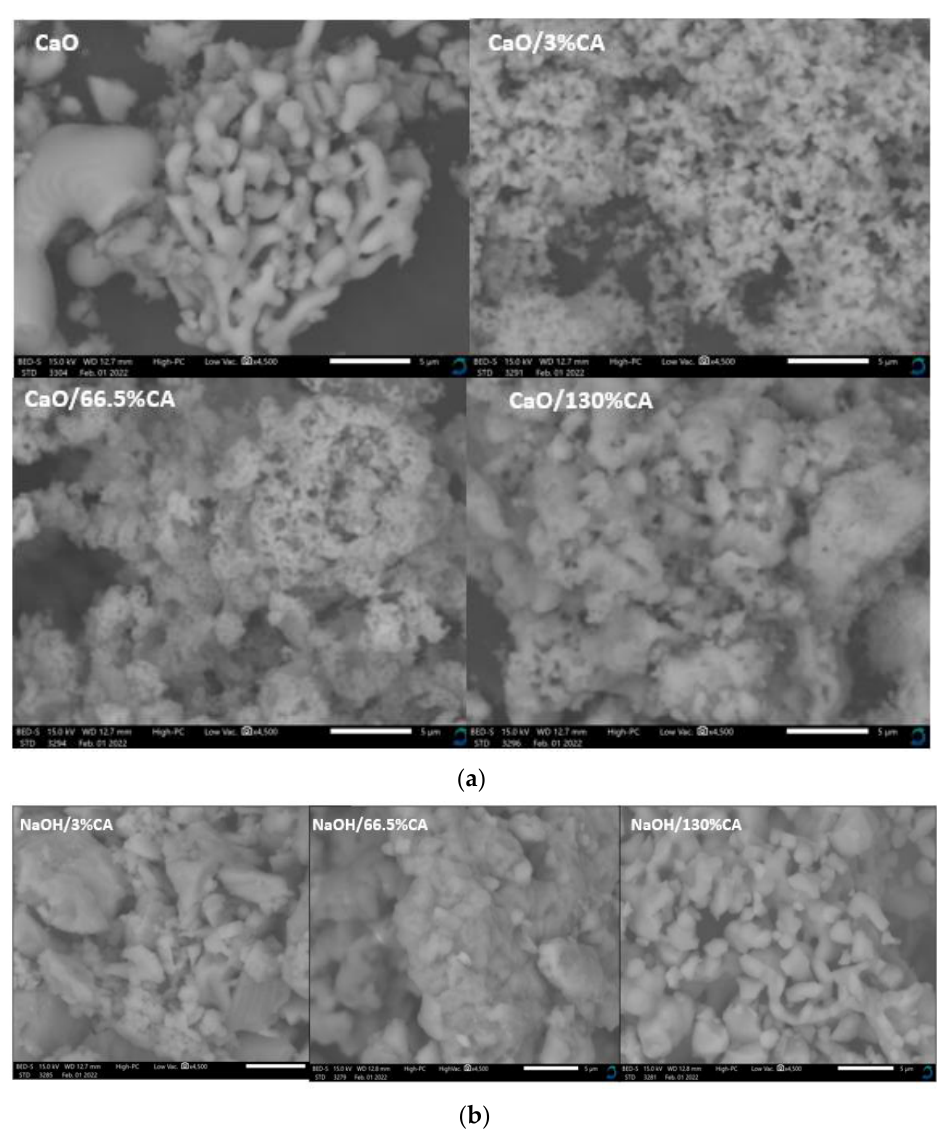
Figure 3. SEM micrographs of the catalysts with varied wt.% loading of citric acid: ( a ) CaO/CA catalysts; ( b ) NaOH/CA catalysts. catalysts; ( b ) NaOH/CA Table 2. XRD Structural properties and catalytic activity of synthesized catalysts.